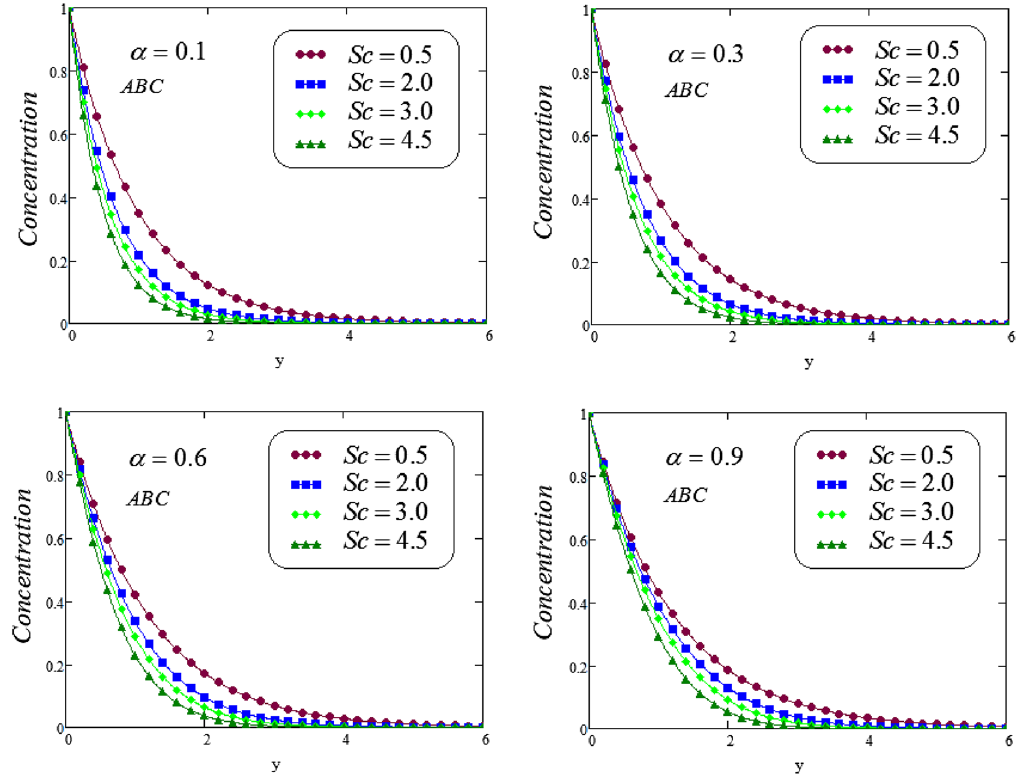
Figure 5. Representation of concentration profile via ABC for distinct values of Sc at distinct values of the fractional parameter α .